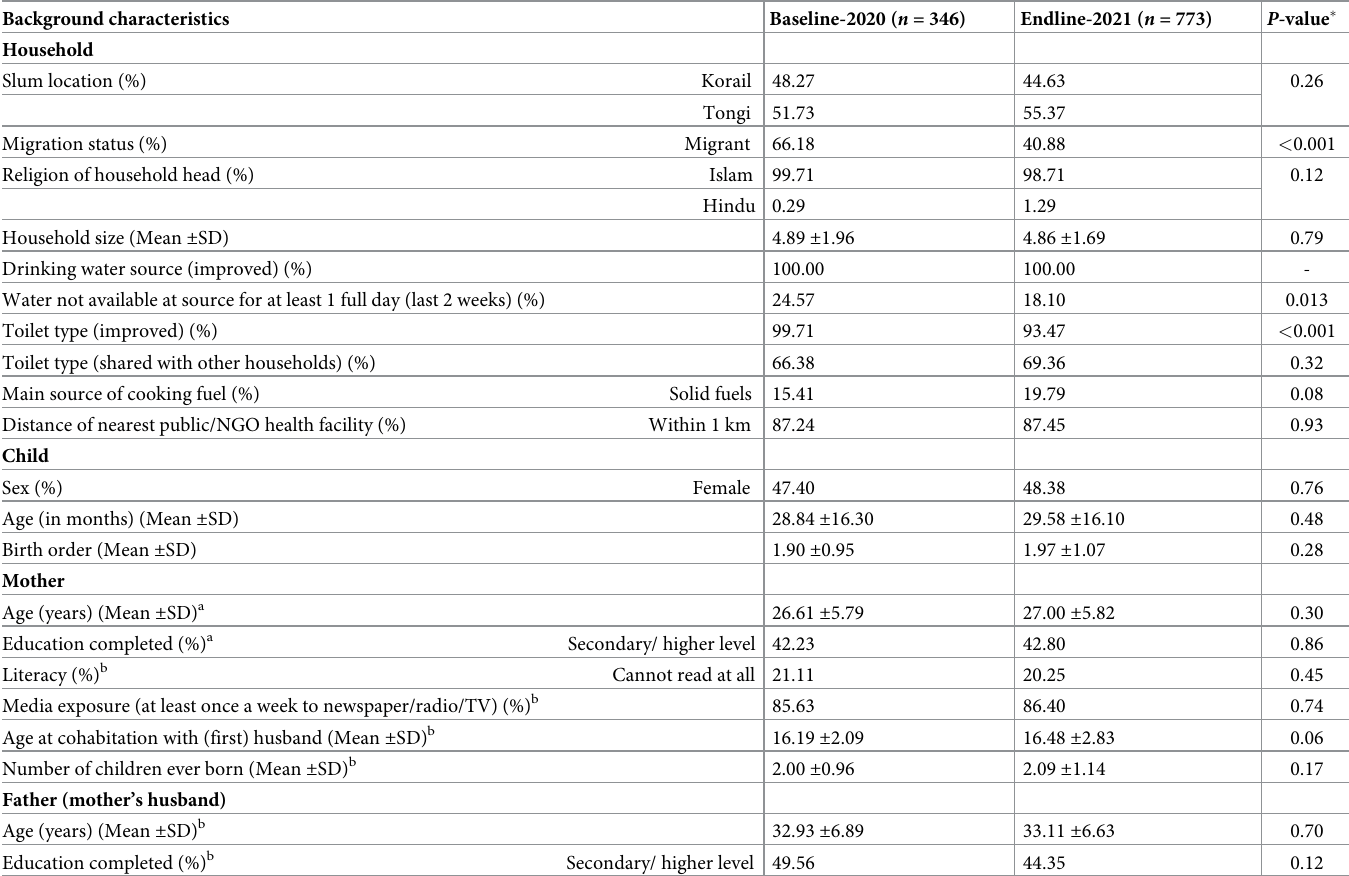
Table 1. Background characteristics of respondents at baseline and